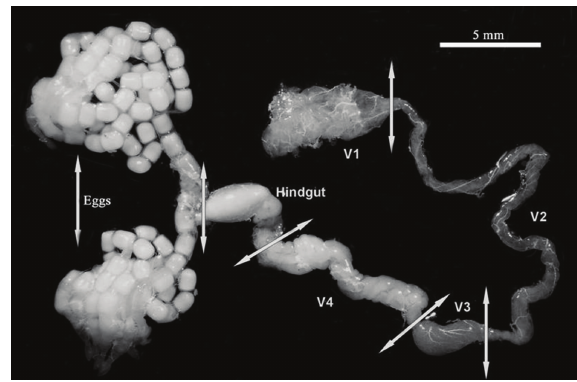
Figure 2: Detailed figure of the midgut of Nezara viridula divided into four ventricles. V4 is the gastric caeca, where the symbionts are located